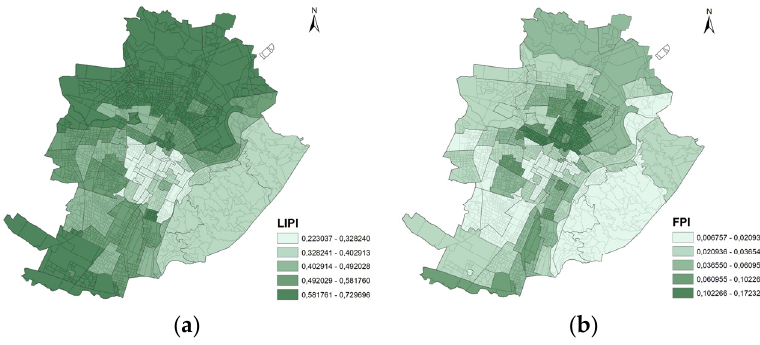
Figure 4. Trends in the two indicators across 93 HTUs of Turin: ( a ) LEPI, census data of 2011; ( b ) FPI, census data of 2011. (Source: Authors’ elaboration).